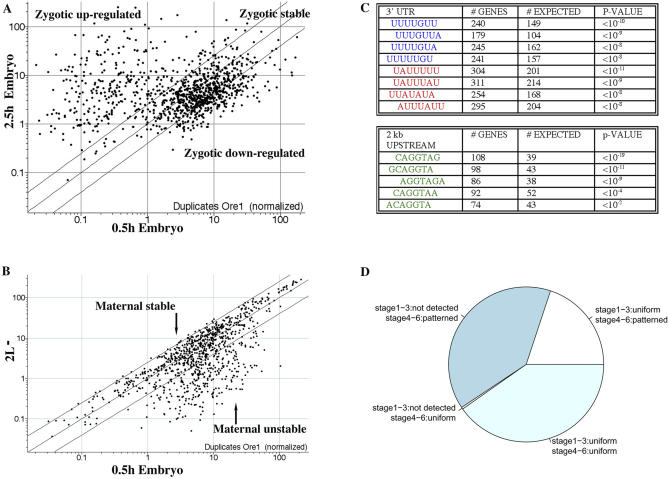
Motif Analysis of Maternal and Zygotic Genes(A) The complete sets of zygotic genes identified in the chromosomal deletion experiments (using the 3-fold cut-off and p < 0.001) were plotted in the time-course experiments (two biological replicates for each time point. The scatter plot was generated using the average of the two measurements). This graph demonstrates that zygotic genes can be up-regulated, down-regulated, or remain unchanged during the MZT. Increase in gene expression over time can only identify one third of the zygotic genes.(B) Stability of maternal transcripts: the expression value of 2L genes in freshly fertilized eggs (0.5 h, the average of two biological replicates is plotted) was compared to the expression value of these genes in embryos missing 2L at (2.5 h, average of four biological replicates is plotted). Under this condition, the stability of a specific transcript is solely dependent on its decay kinetics.(C) Motif discovery in the 3′ UTR of maternal unstable transcripts (upper table, the first motif is in red and the second is in blue) and in the 2-kb upstream regions of purely zygotic genes (lower table, in green). The UUGUU sequence resembles the target site for the PUF family of RNA-binding proteins, and the UAUUUAU motif resembles the AU-rich element.(D) BDGP in situ database analysis showing the expression pattern of the different categories of zygotic genes. Stage 1–3 corresponds to maternal stages (0–2 h), and 4–6 to zygotic stages (2–4 h).